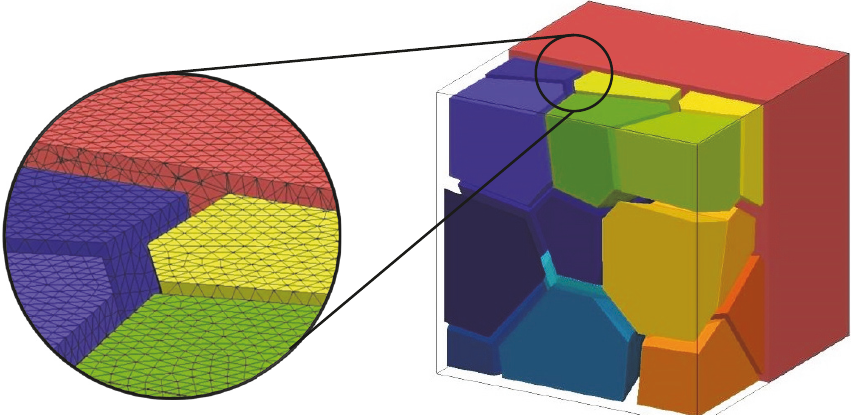
Figure 1: Micromagnetic finite element model structure with 29 Voronoi grains separated by a GB-phase with a thickness of about 10% of the grain